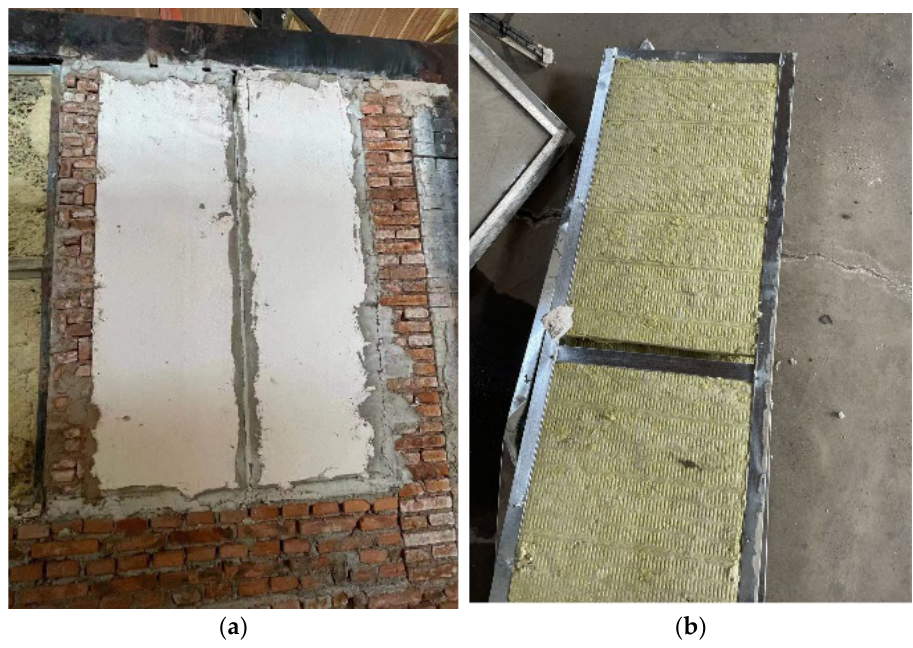
Figure 10. Fire surface ( a ) and sandwich insulation ( b ) of ALC sandwich wall panels after fire test.